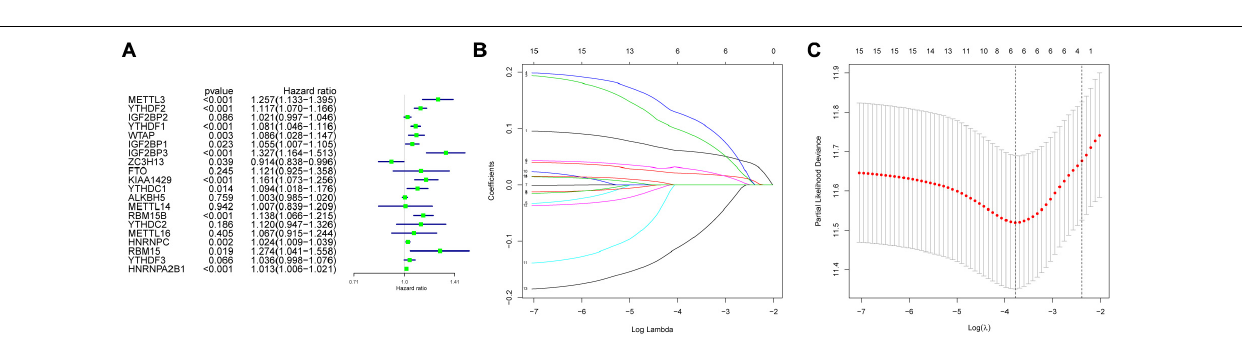
FIGURE 5 | Spearman’s correlation analysis and functional annotations of 20 m6A-related genes. (A) GO annotation. (B) Spearman correlation analysis in 20 m6A modification regulators genes in LIHC. (C) String protein–protein interaction network. LIHC, liver hepatocellular carcinoma.